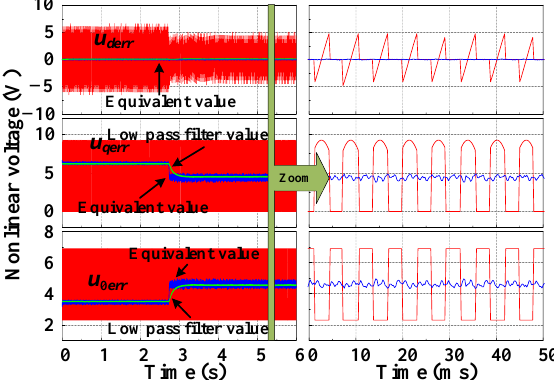
Figure 13. Nonlinear voltage and its equivalent value ( i 0 changes).